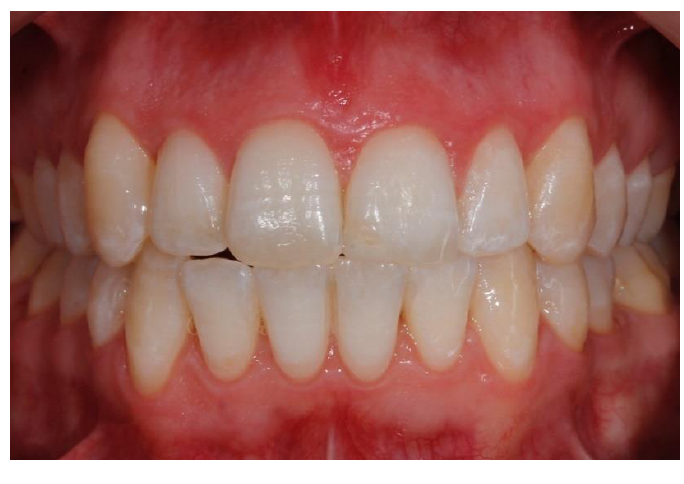
Figure 3. Group 1 patient (35% HP, Quick White kit Clínica, Quick White): ( A ) pre-treatment image; ( B ) post-treatment image.